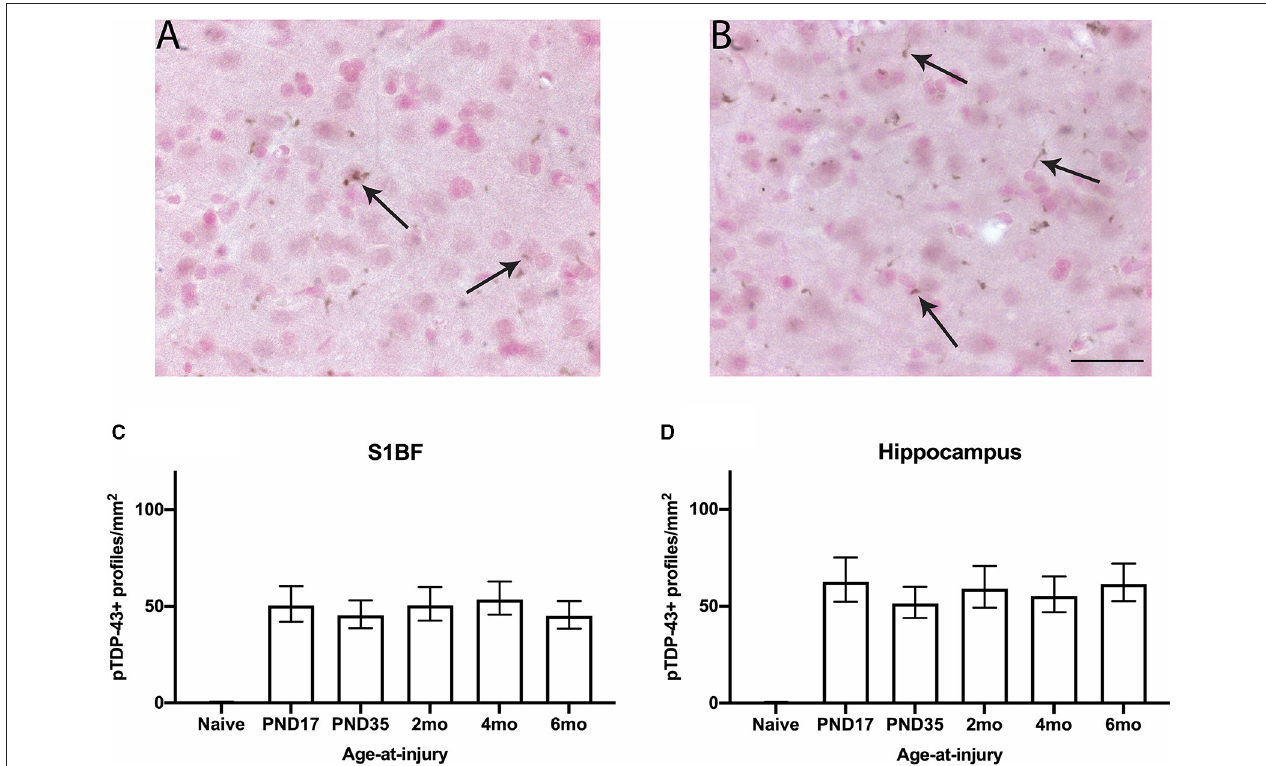
FIGURE 4 | pTDP-43 neuronal profiles were quantified in the S1BF and hippocampus. Indicative images of neuronal pathology visualized by pTDP-43 immunohistochemistry were taken in the primary sensory barrel field (S1BF) of rats injured at 6-months of age. Quantitative analysis included nuclei inclusions (A) and cytoplasmic neurites (B) indicated by the black arrows (scale bar = 50 µ m). Counts of neuronal pathology are expressed as the number of pTDP-43 + profiles/mm 2 (mean ± 95%CI) in the S1BF and hippocampus. Significantly more pTDP-43 + profiles were observed following mFPI, regardless of age-at-injury, compared to naïves in both the S1BF (C) and the hippocampus (D)